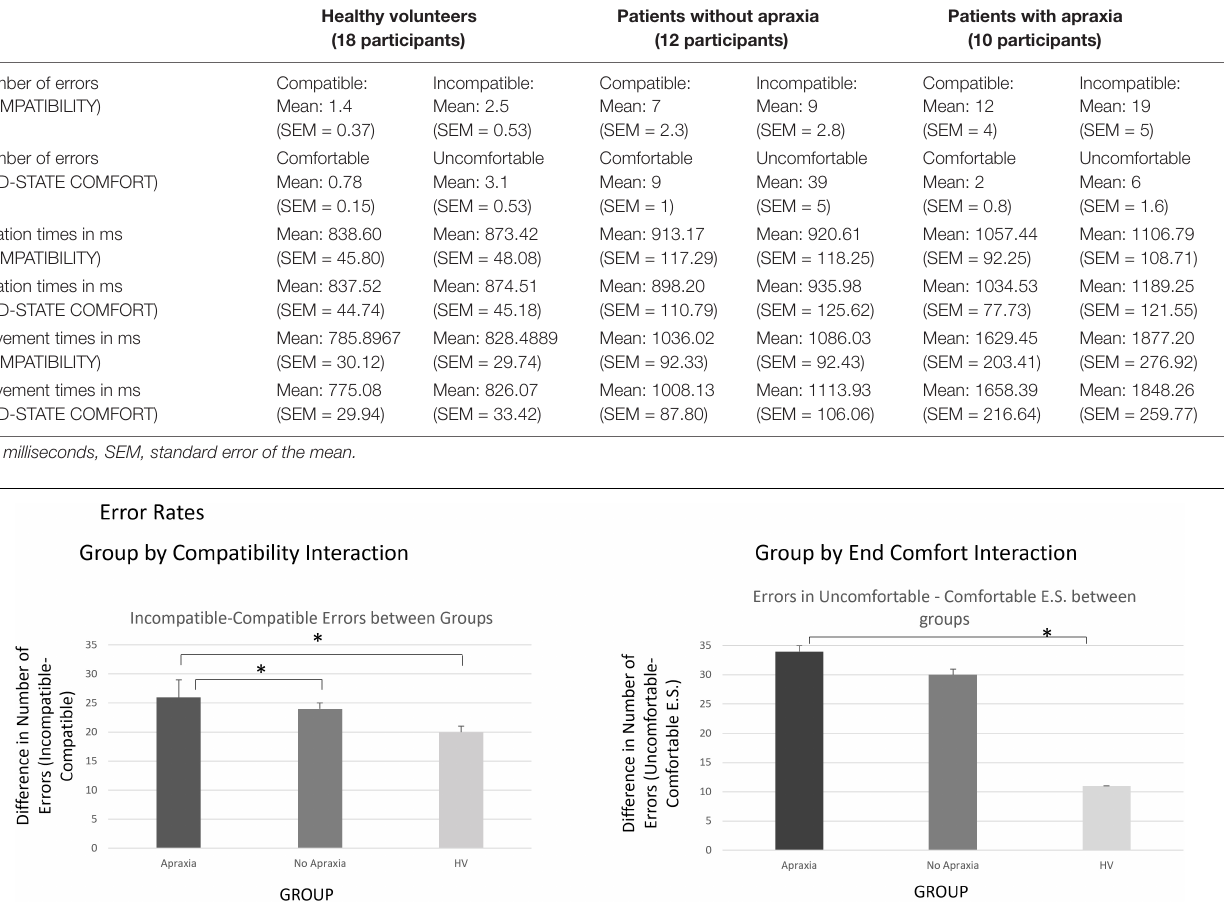
Patients with apraxia (10